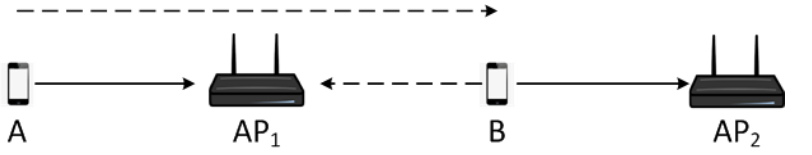
Figure 2. A hidden terminal scenario. Node B is hidden to node A, and the packet at AP 1 is lost when both node A and B transmit together.